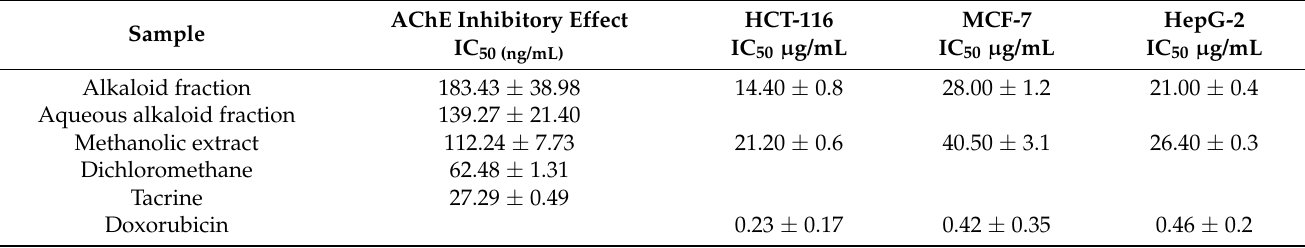
Table 3. Cytotoxic and anticholinestrase activities of the A. canariense L.